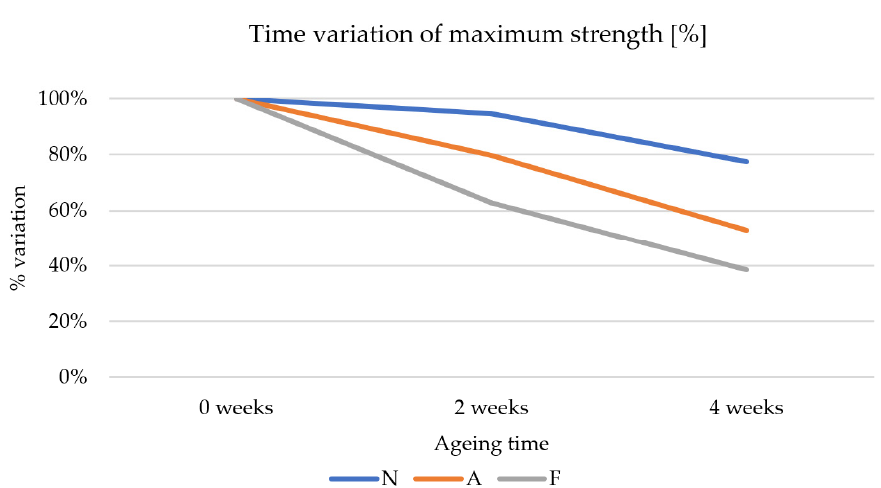
Figure 3. Maximum strength percent variation compared to virgin film (i.e., initial value N0 = 100%) on aged PE-LD plastic film with no contamination (N), one spraying with anti-aphid insecticide (A) and one spraying with fungicide (F).